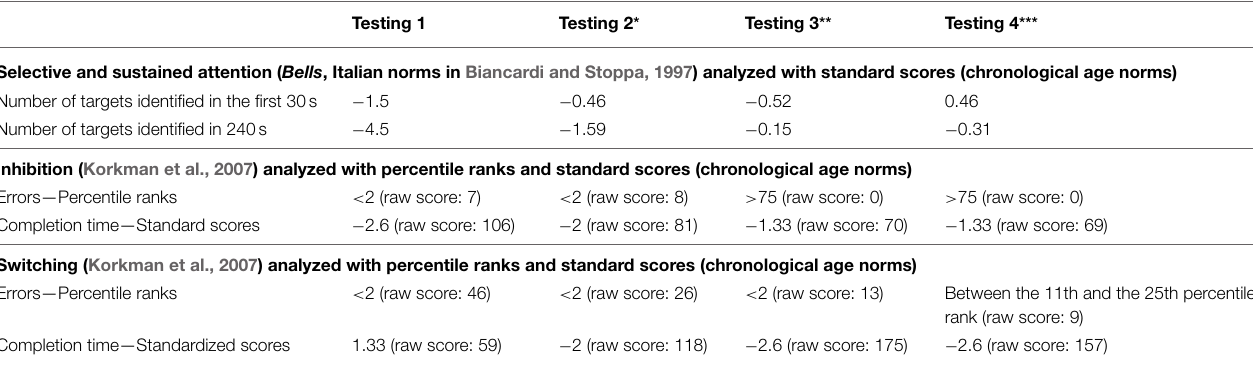
TABLE 3A | Effects of treatment on attention, inhibition, and